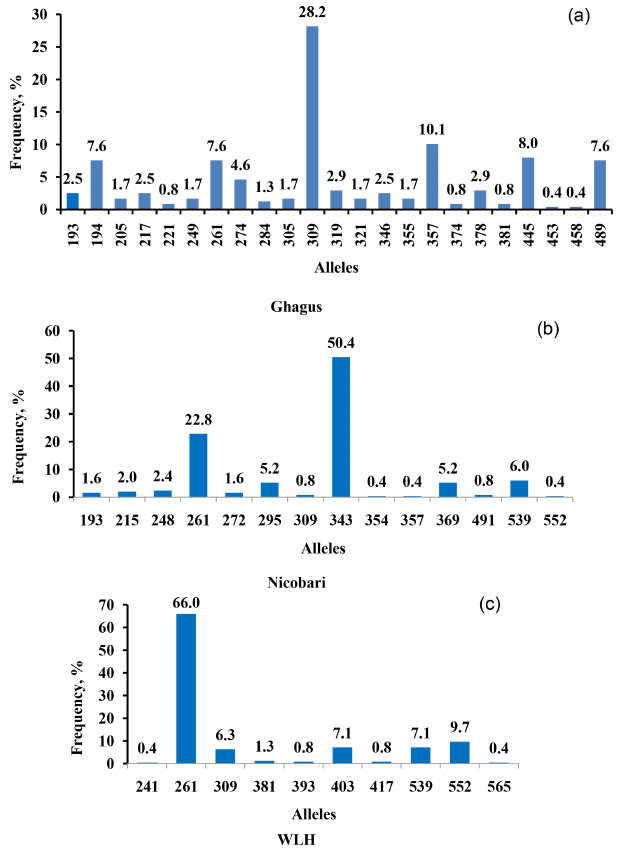
Figure 1. Allele frequency of LEI0258 locus in (a) Ghagus, (b) Nicobari and (c) WLH